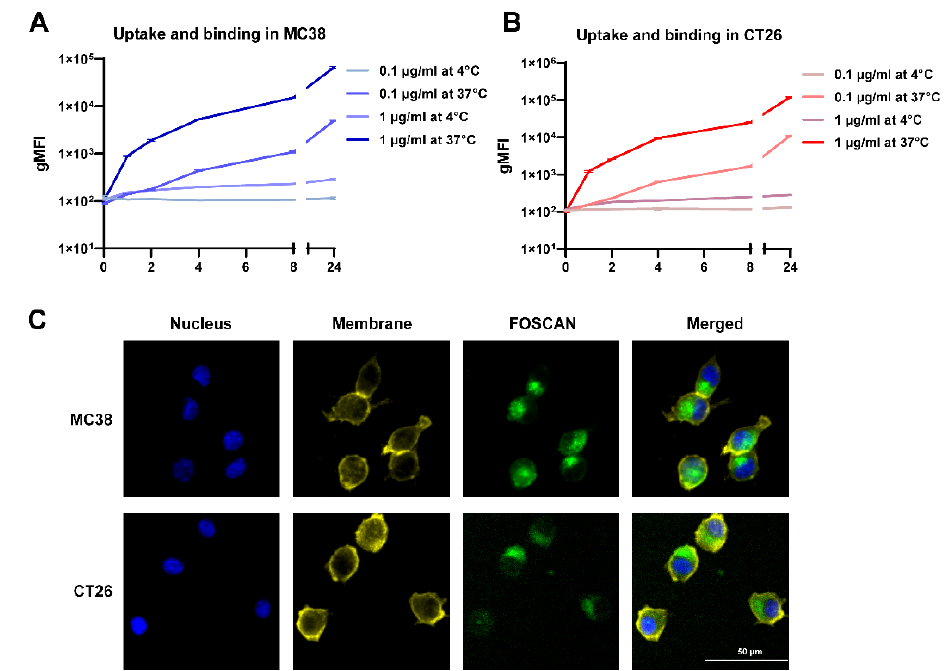
Figure 1. Cellular uptake, binding, and intracellular fluorescence images of FOSCAN in vitro. Uptake (37 °C) and binding (4 °C) assays with either 0.1 µg/mL or 1 µg/mL FOSCAN in ( A ) MC-38 cells and ( B ) CT-26 cells at indicated time points (0 h, 1 h, 2 h, 4 h, 8 h, and 24 h). The graph shows the mean gMFI ± SEM of cells by flow cytometry analysis from three independent experiments. Typical fluorescence microscopy images of ( C ) MC-38 and CT-26 were taken 24 h after incubation with 1 µg/mL FOSCAN. Nuclei (blue), Membrane (yellow), and FOSCAN (green). Scale bar = 50 μm.